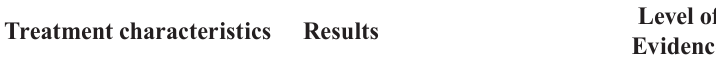
TABLE I - S ummary of clinical studies that were included in this systematic